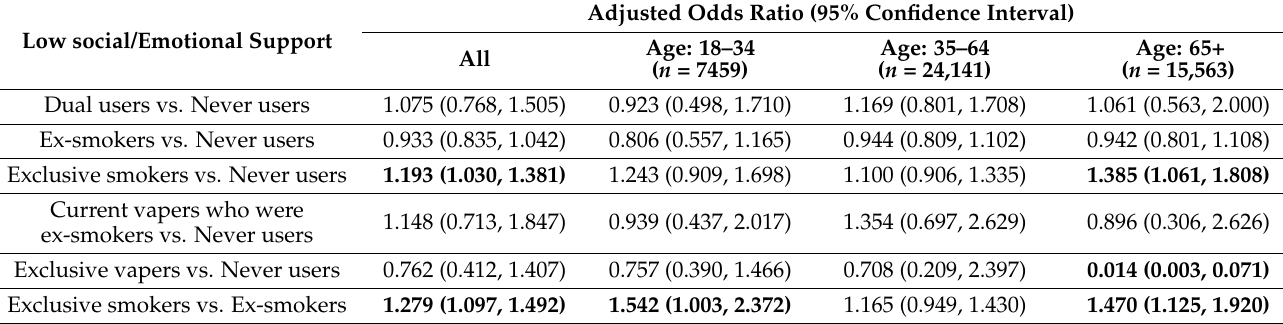
Table 3. Association of social/emotional support with smoking/vaping